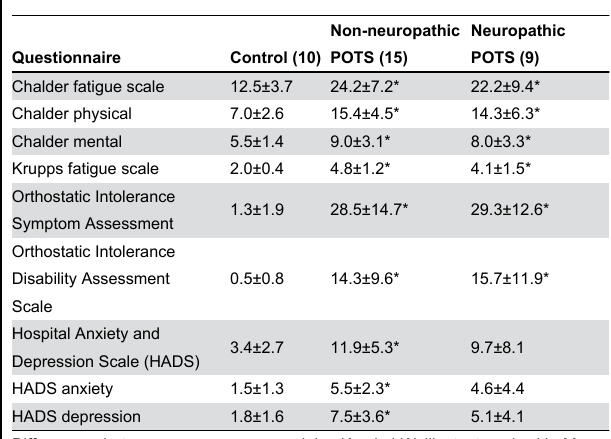
Table 3. Questionnaire